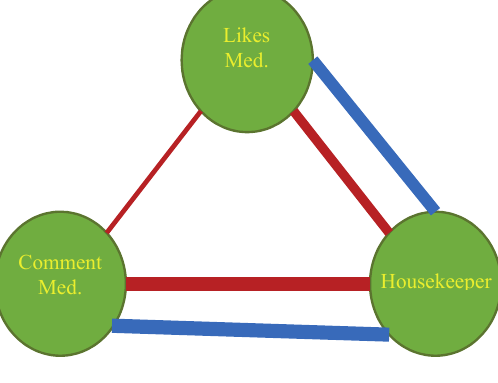
Fig.e 8. Extracted graph